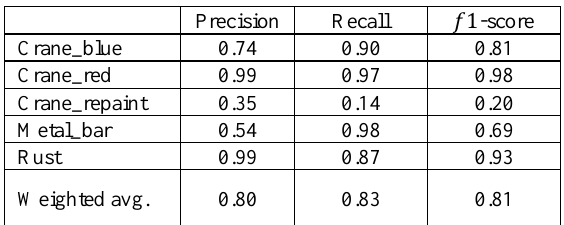
Table 2. Results on test set of Naïve Bayes